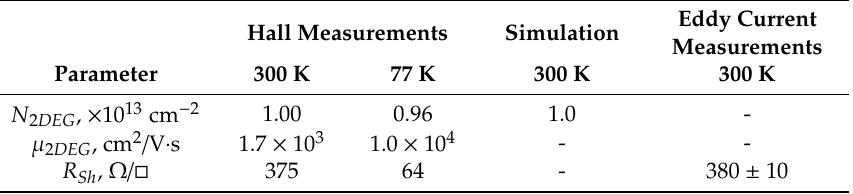
Table 1. Parameters of 2DEG in T-HEMT heterostructures at 300 K and 77